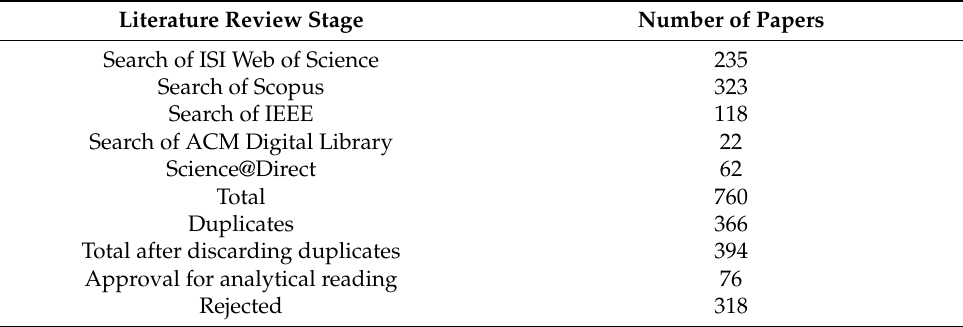
Table 1. Summary of literature review